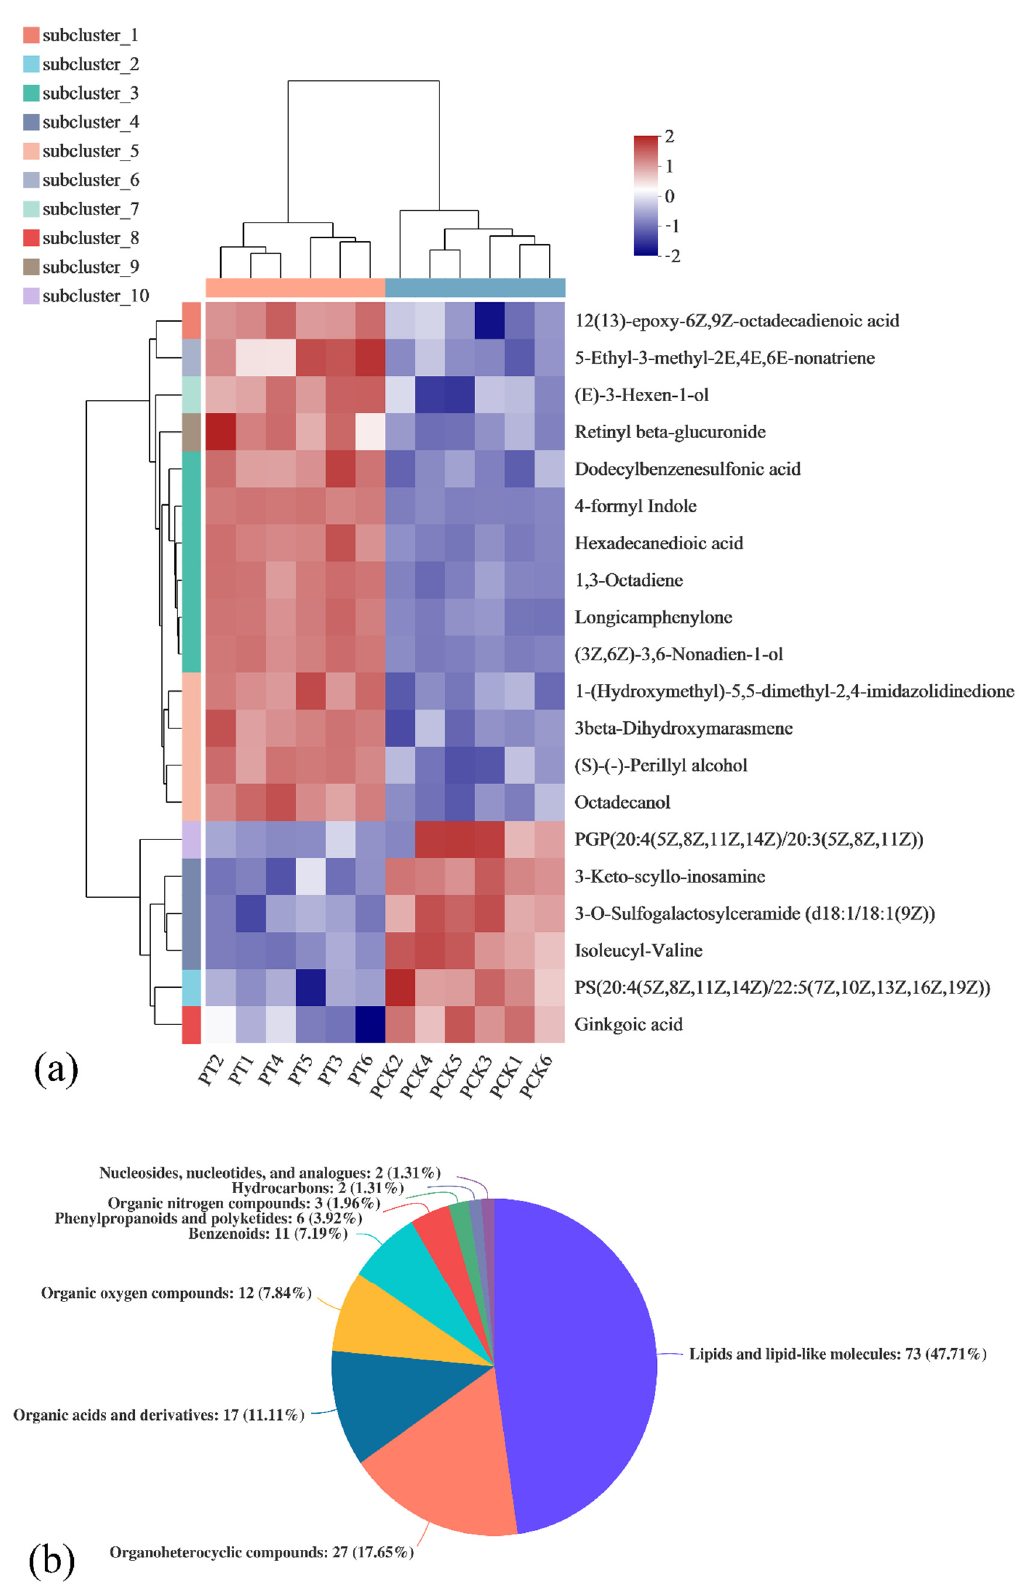
Figure 3. Comparison of the relative abundance of metabolites in PT (PT1, PT2, PT3, PT4, PT5, and PT6) vs. PCK (PCK1, PCK2, PCK3, PCK4, PCK5, and PCK6) groups ( a ), relative abundance of metabolites of light-treated and untreated P. palleroniana ( b ).